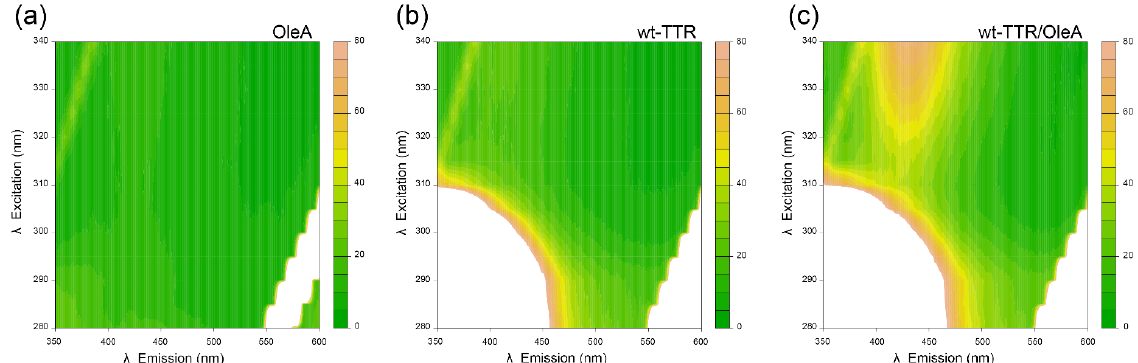
Figure 2. Excitation − emission matrices (EEM) in the 280–340 nm excitation range and in the 350–600 nm emission range. The samples tested were ( a ) OleA, ( b ) wt-TTR, and ( c ) the complex wt-TTR/OleA incubated at pH 7.0 and 37 °C for 24 h. In all matrices, the white-colored band on the bottom right corner corresponds to the harmonic (double wavelength) of the incoming light, which gives an intense signal that reaches the top-scale; the small yet detectable signal in the top left corner (emission–excitation coordinates going from 350–315 to 400–340 nm) corresponds to the Raman scattering of water.